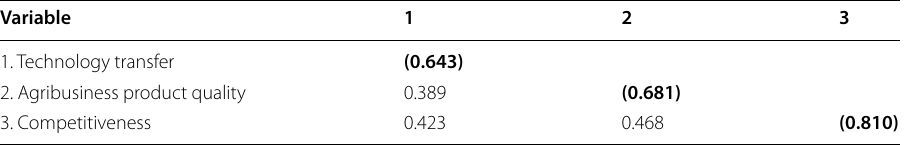
Bold values refer to AVE of each construct Numbers on the first row refer to corresponding variables on the first column Table 3 HTMT ratios of construct correlations